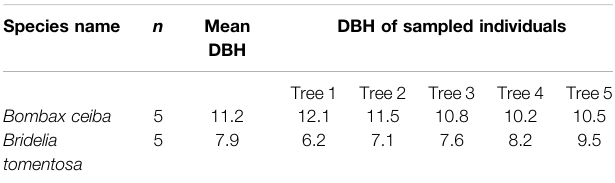
Table1| MeanDBH(incm)of Bombaxceiba and Brideliatomentosa inBaopoling Mountain and DBH values (in cm) of the sampled individuals (n) for Bombax ceiba and Bridelia tomentosa ,